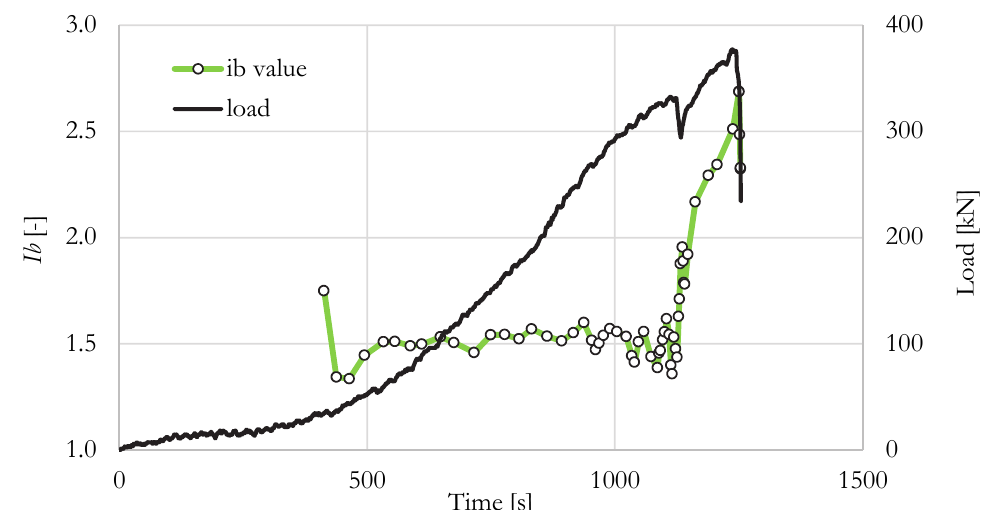
Figure 10: Time variation of the Ib -value in juxtaposition to the respective variation of the load imposed load drop caused by the local fracture of the upper corner of one of the two fragments (Fig.4), which results, in fact, to an